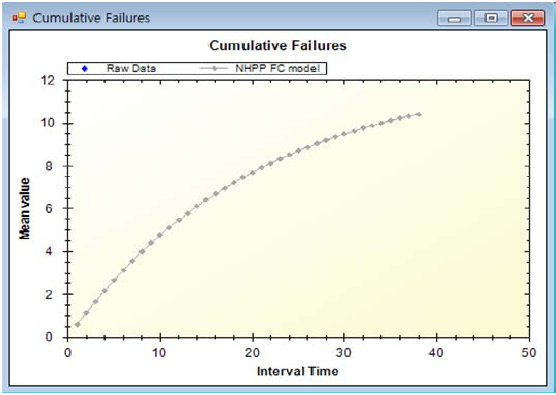
Fig. 9. Estimation Values of Goel-Okumoto Model